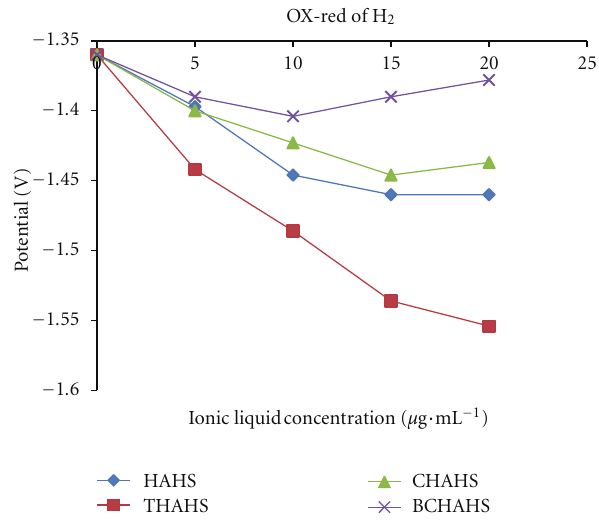
Figure 2: E ff ect of di ff erent ILs and their concentrations on the hydrogen evolution overpotential of Pb-1.6% Sb-Sn alloy in 4.0moldm − 3 H 2 SO 4 , scan rate 50.0 mVs − 1 , and current density of 8.0mAcm − 2 for the cathodic scan.